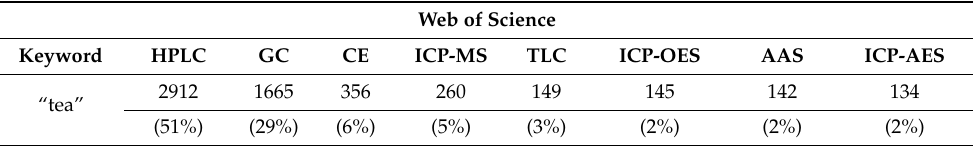
Table 1. Number of papers published in the Web of Science database using various analytical